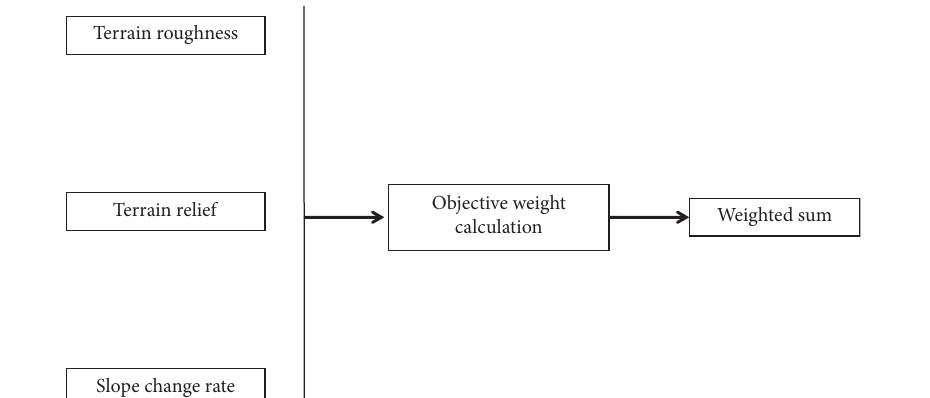
Figure 7: Scatter diagram of connected Bao for each environmental factor.